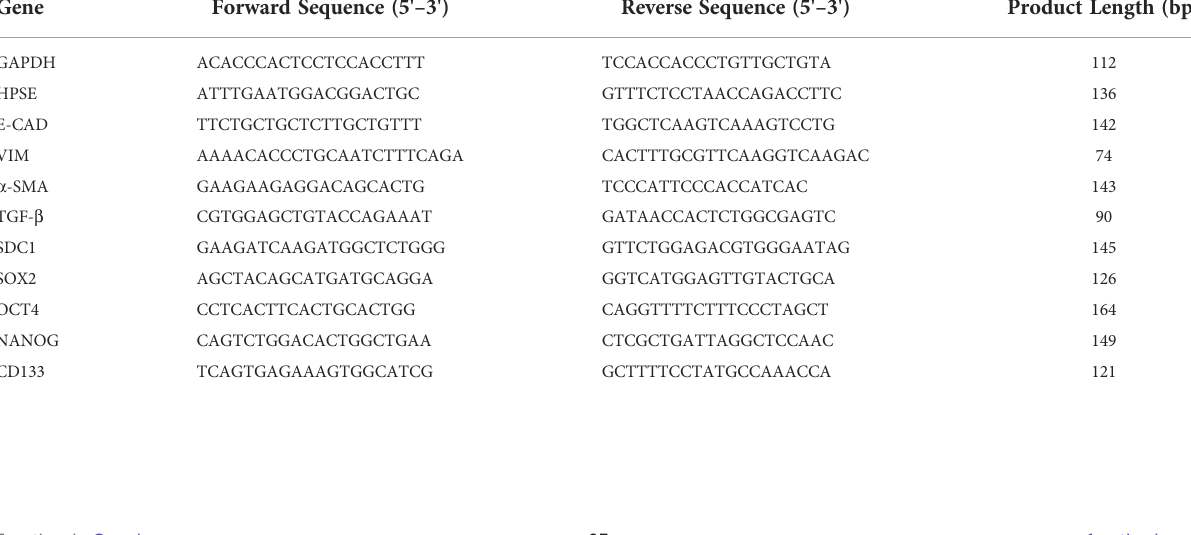
TABLE 1 Primer sequences used for real-time PCR